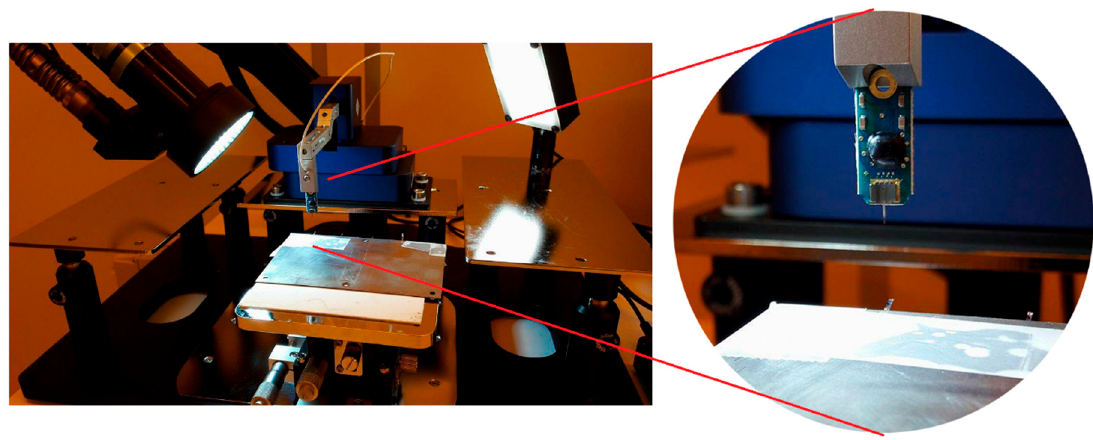
Figure 4. Test setup for measuring bending stiffness using the Femtotools FTA-M02 micromechanical testing system. Close-up shows the vertical indenter probe with integrated force sensor. Reproduced with permission from [31]; published by IOPscience, 2017.